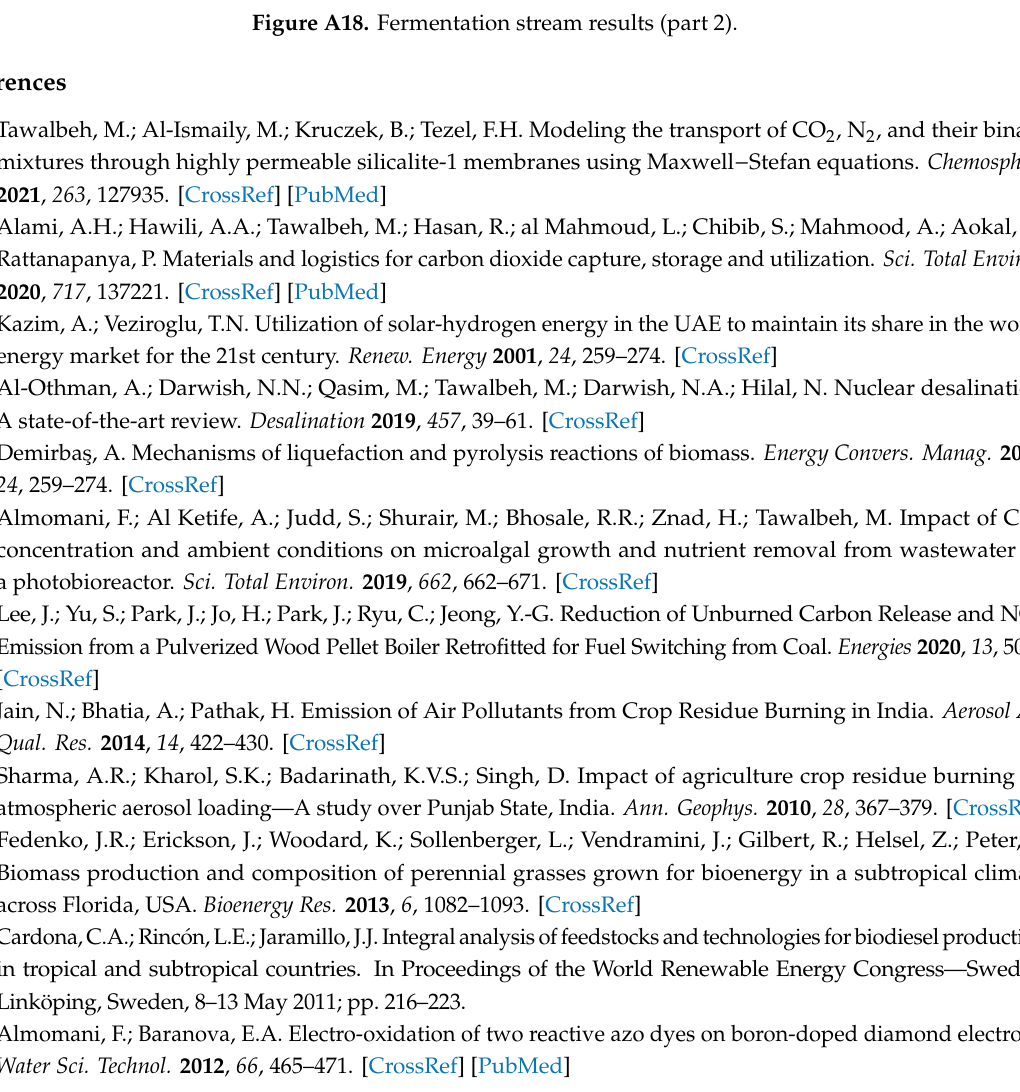
Figure A18. Fermentation stream results (part 2).